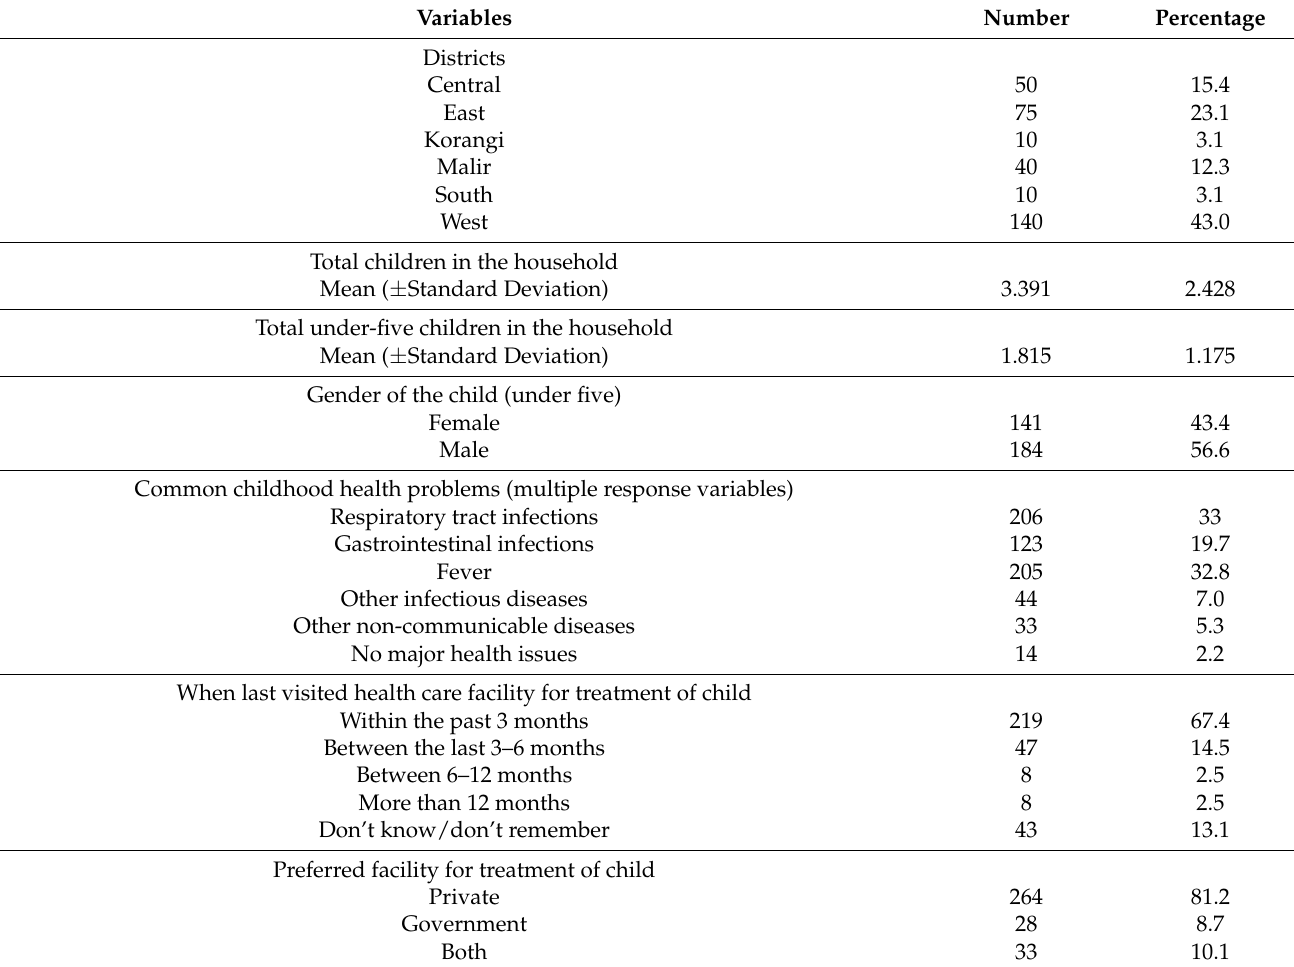
Table 1. Characteristics of study participants in 34 high-risk union councils of Karachi division, Sindh,